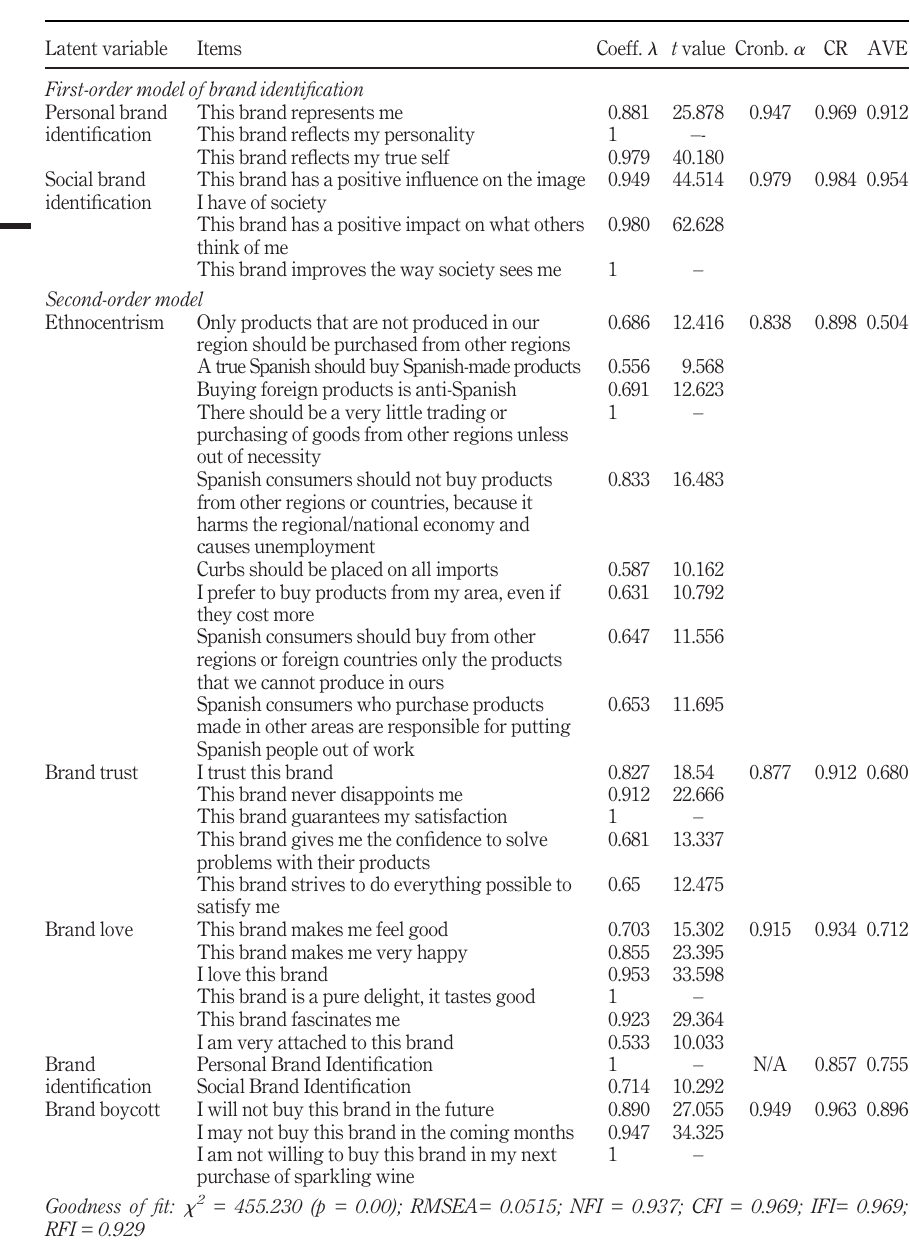
Table 2. First- and second- order measurement models